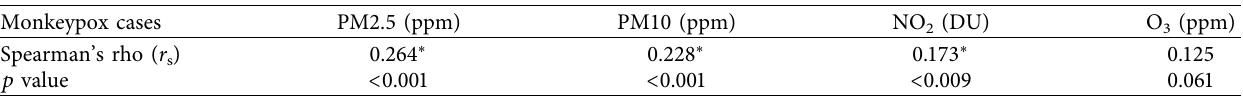
Table 4: Spearman’s Rho correlation between PM2.5, PM10, NO and European